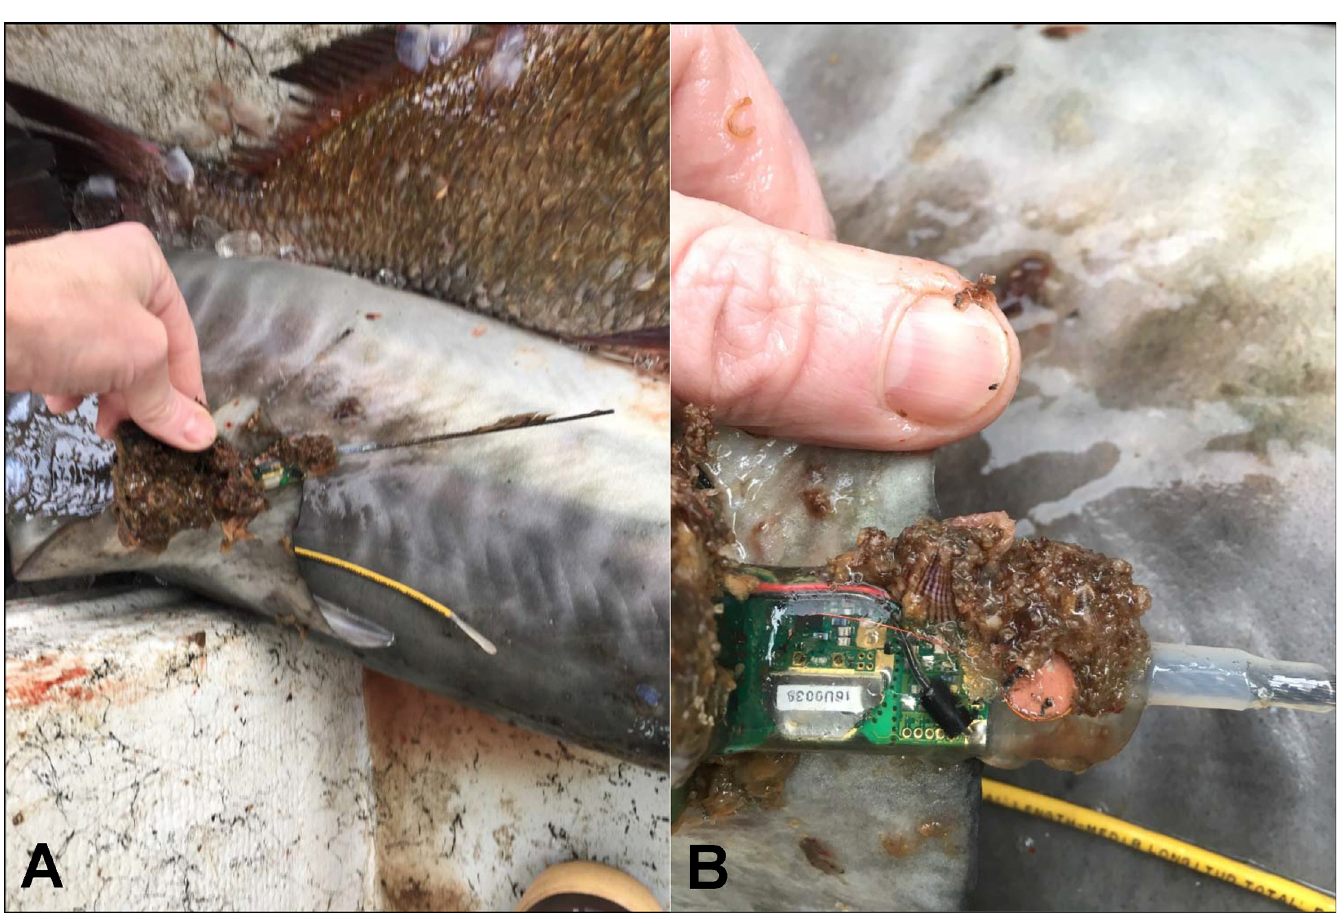
Fig 8. Photographs of a recaptured shark and transmitter. Photographs indicate biofouling on Wildlife Computers SPOT 258-A from Shark-45 after 7 months at liberty. Photos show an overview of the tag and relative placement on the dorsal fin (A), and a closeup of the wet-dry sensors and other internal components (B).